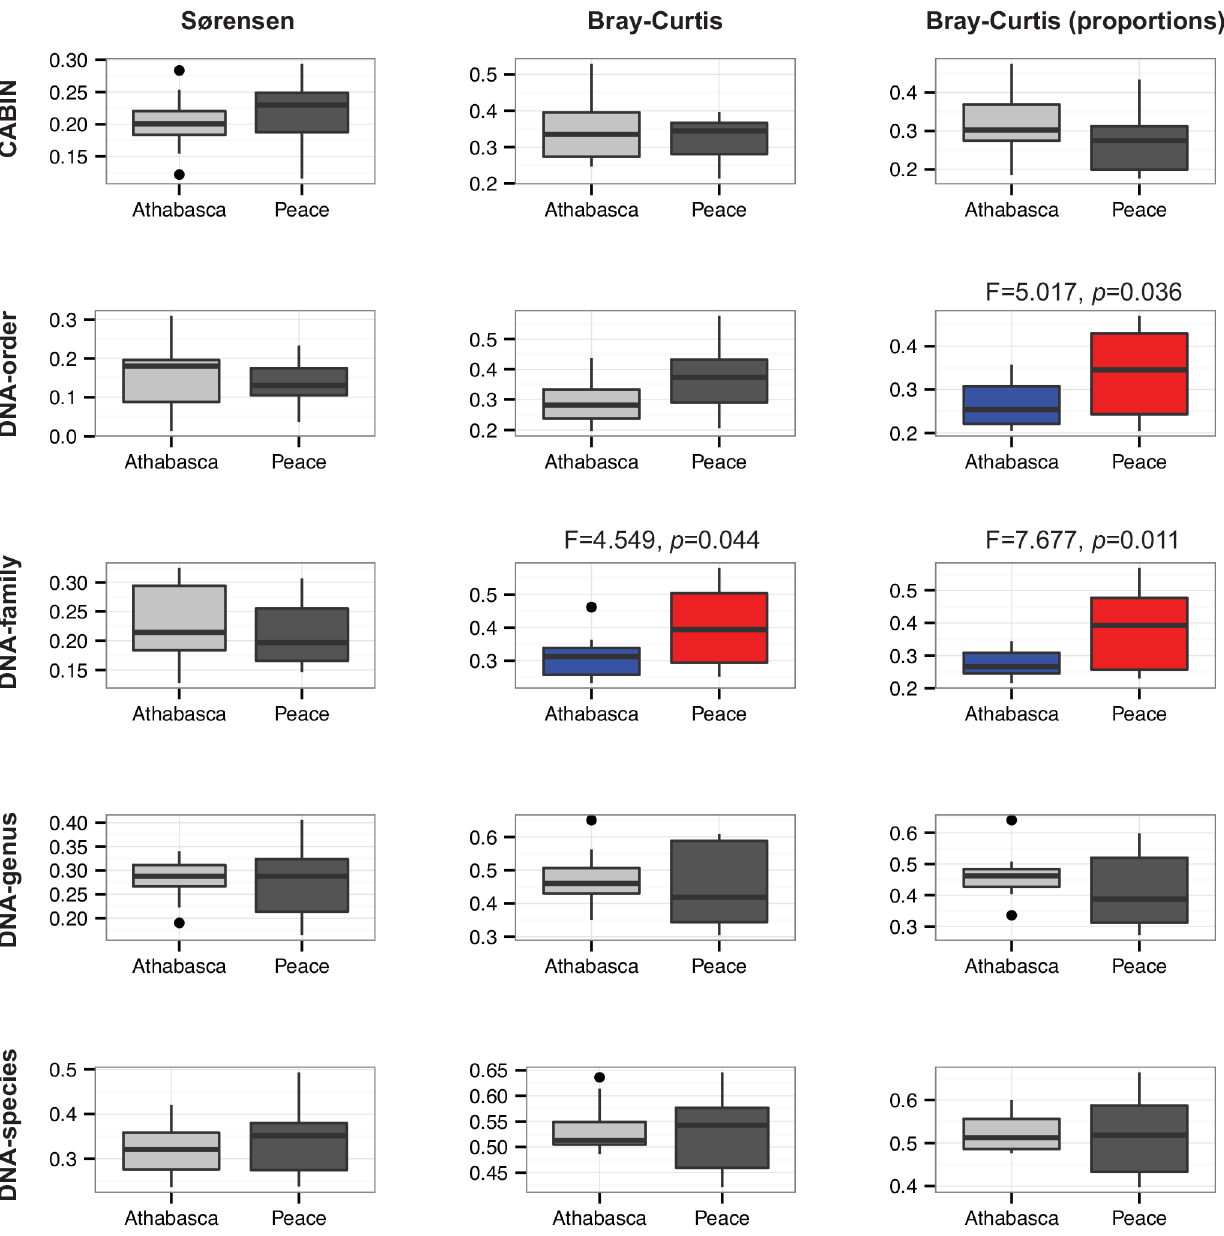
Fig 3. Community assemblage measures for 24 benthic samples from the Peace-Athabasca delta at five different taxonomic levels via morphological identification and HTS. Box and whisker plots of distance to centroid in principal coordinate space based on three dissimilarity measures – S ø rensen, Bray-Curtis based on sequence number, and Bray-Curtis based on proportions of sequences. Significant differences ( p < 0.05) between Athabasca and Peace sites are highlighted in